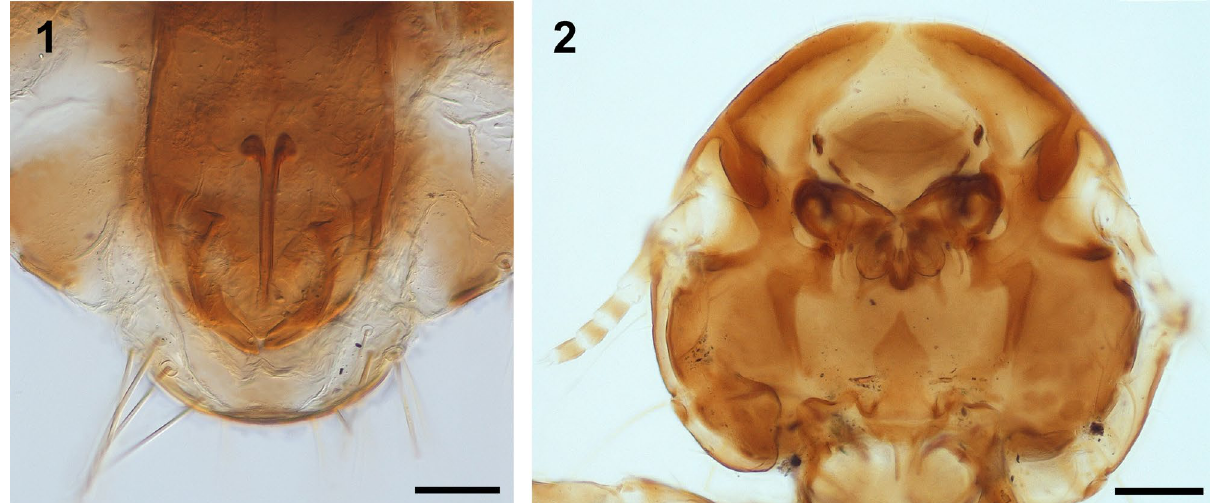
Figure 1. (1) Degeeriella punctifer . Male genitalia. Scale bar: 100 µm, ( 2 ) Degeeriella punctifer . Head shape. Scale bar: 100